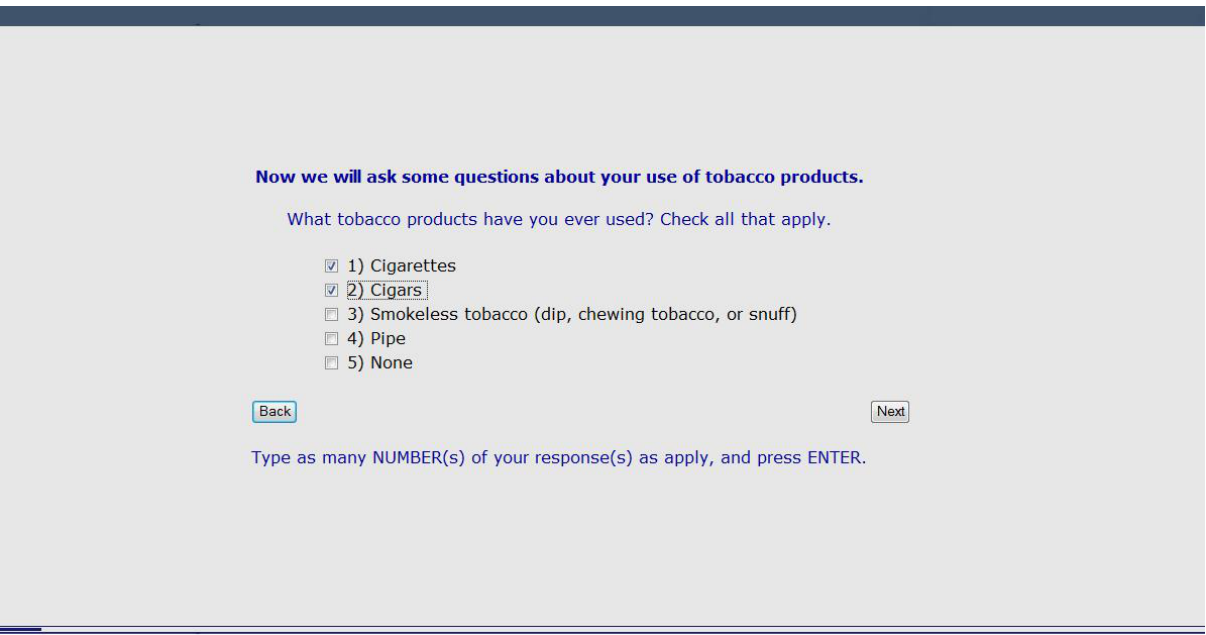
Figure 3. Screenshot from the CABIT program showing questions about tobacco products used.